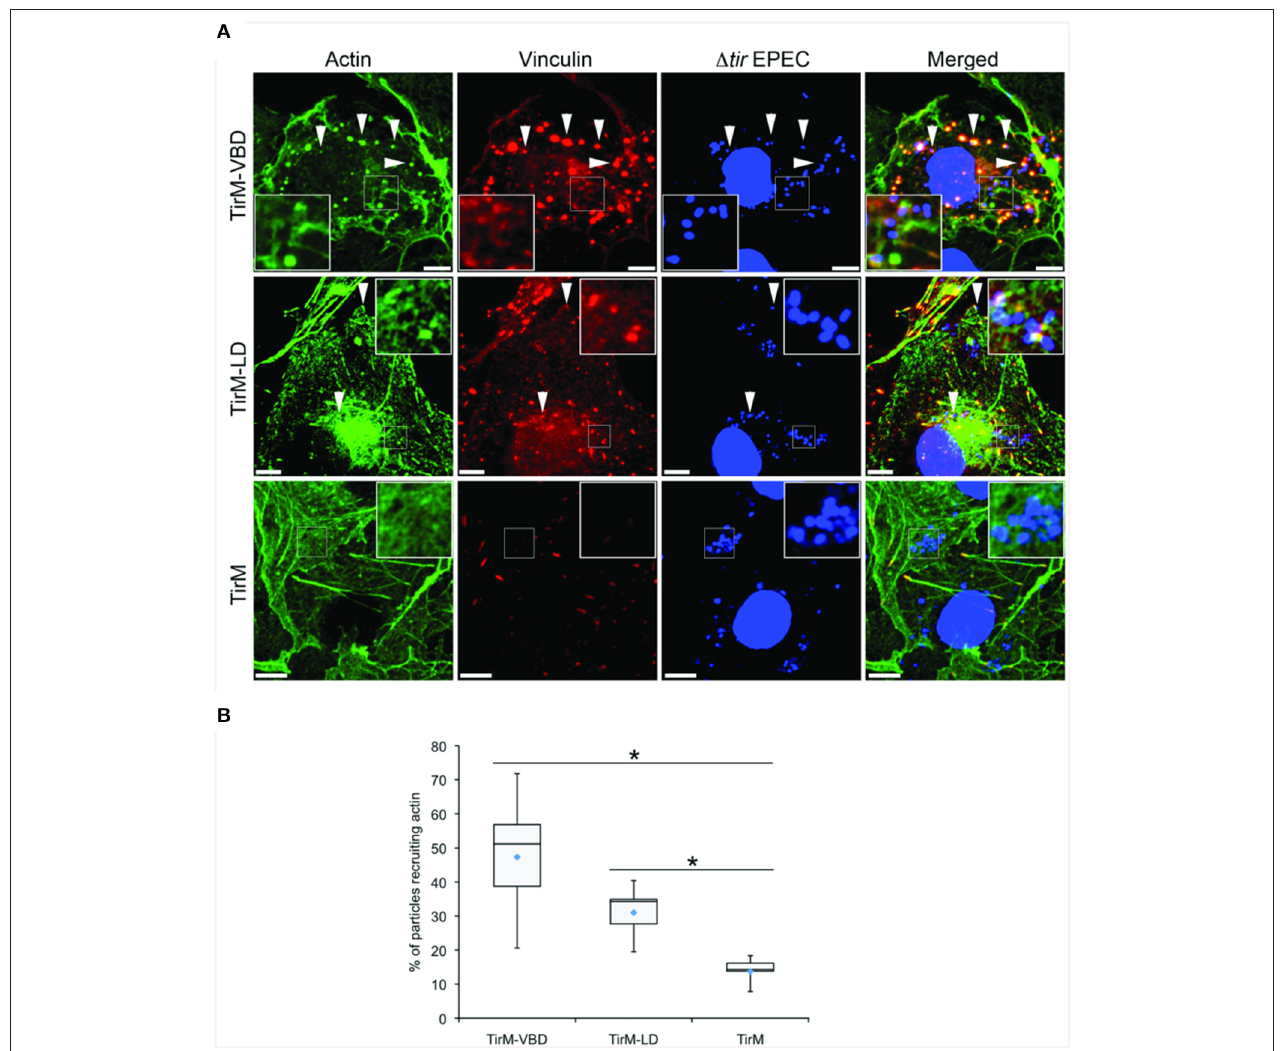
FIGURE 5 | The vinculin binding domain mediates the recruitment of both vinculin and actin. (A) Cos7 cells transfected with the plasmid encoding the TarP Vinculin Binding Domain (TirM-VBD), the LD domain (TirM-LD), or the control vector TirM were infected with 1 tir EPEC to induce clustering of the proteins. Transfected cells were identified by staining for the HA-tag present in the fusion proteins. The white arrowheads indicate colocalization of actin and vinculin with adhered 1 tir EPEC. Filamentous actin (green) and vinculin (red) were visualized with phalloidin or an anti-vinculin antibody, respectively. Bacteria (blue) were visualized by DAPI. Scale bars: 10 µ m. (B) Adhered EPEC able to recruit actin were enumerated and data represented as box and whisker plot. Data compiled from three independent experiments. Plot shows range, first and third quartiles, and overall median (horizontal line). Diamonds indicate means. A range of 600–730 particles was counted. Insets show a magnification of a selected area of the cell. The asterisk and bars indicate significance difference between specific groups (One-way ANOVA, Tukey’s post-hoc test, P < 0.00001